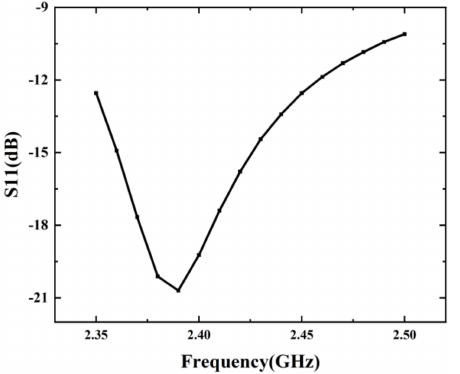
Figure 10. S11 values of the microwave continuous-flow sterilisation system at different